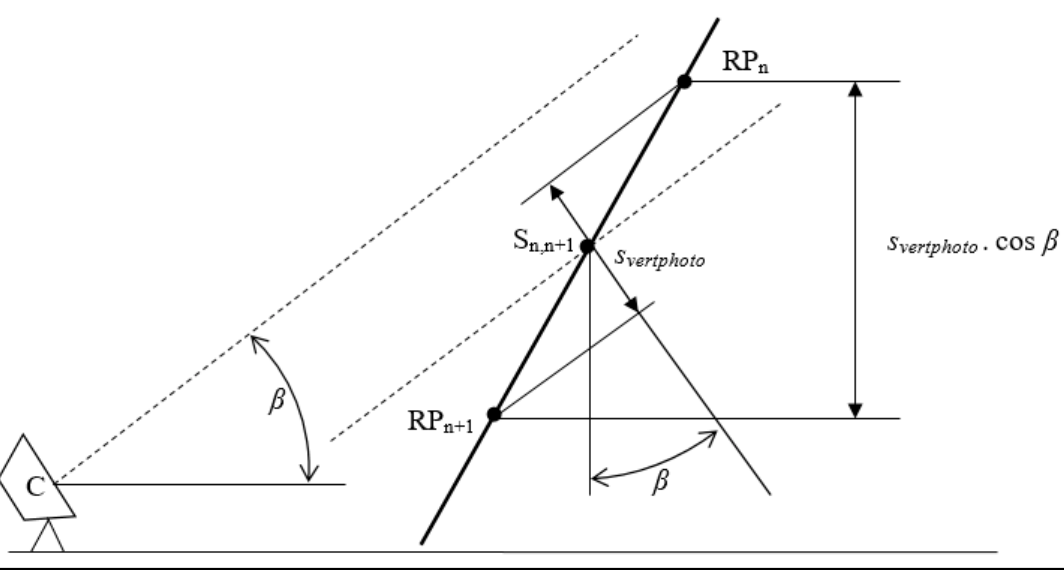
Figure 12. Determination of the vertical distance between the reference points RP n and RP n+1 (source: The authors of this article).